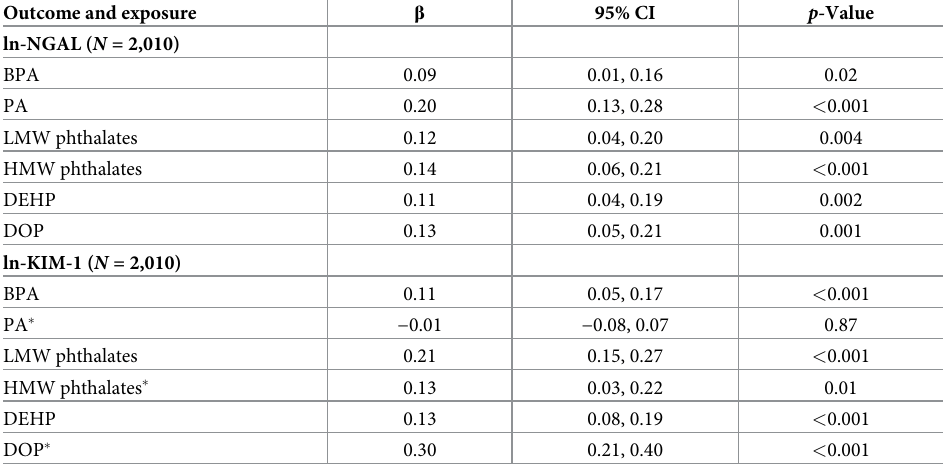
β : estimate per SD change. All models controlled for age, sex, race/ethnicity, glomerular status, birth weight, premature birth, angiotensin receptor blocker, angiotensin-converting enzyme inhibitor, BMI z- score, and systolic blood pressure z- score (all measured at each patient’s first visit) and creatinine. � Exposure has significant interaction with time ( p < 0.05), and estimate for exposure at baseline is presented here; time-specific estimates are plotted in Fig 1. BPA, bisphenol A; DEHP, di(2-ethylhexyl) phthalate; DOP, di-n-octyl phthalate; HMW, high molecular weight; KIM-1, kidney injury molecule-1; LMW, low molecular weight; NGAL, neutrophil gelatinase-associated lipocalin; PA, phthalic acid. BPA, PA, and phthalate metabolite groups were also positively associated with oxidative stress biomarkers, particularly 8-OHdG (Table 5). In addition, PA, ∑ LMW phthalates, and ∑ DOP were associated with increases in F 2 - isoprostane. Associations between BPA and PA and 8-OHdG, and between BPA and ∑ DEHP and F 2 -isoprostane, were shown to increase over the course of follow-up (Fig 2; S4